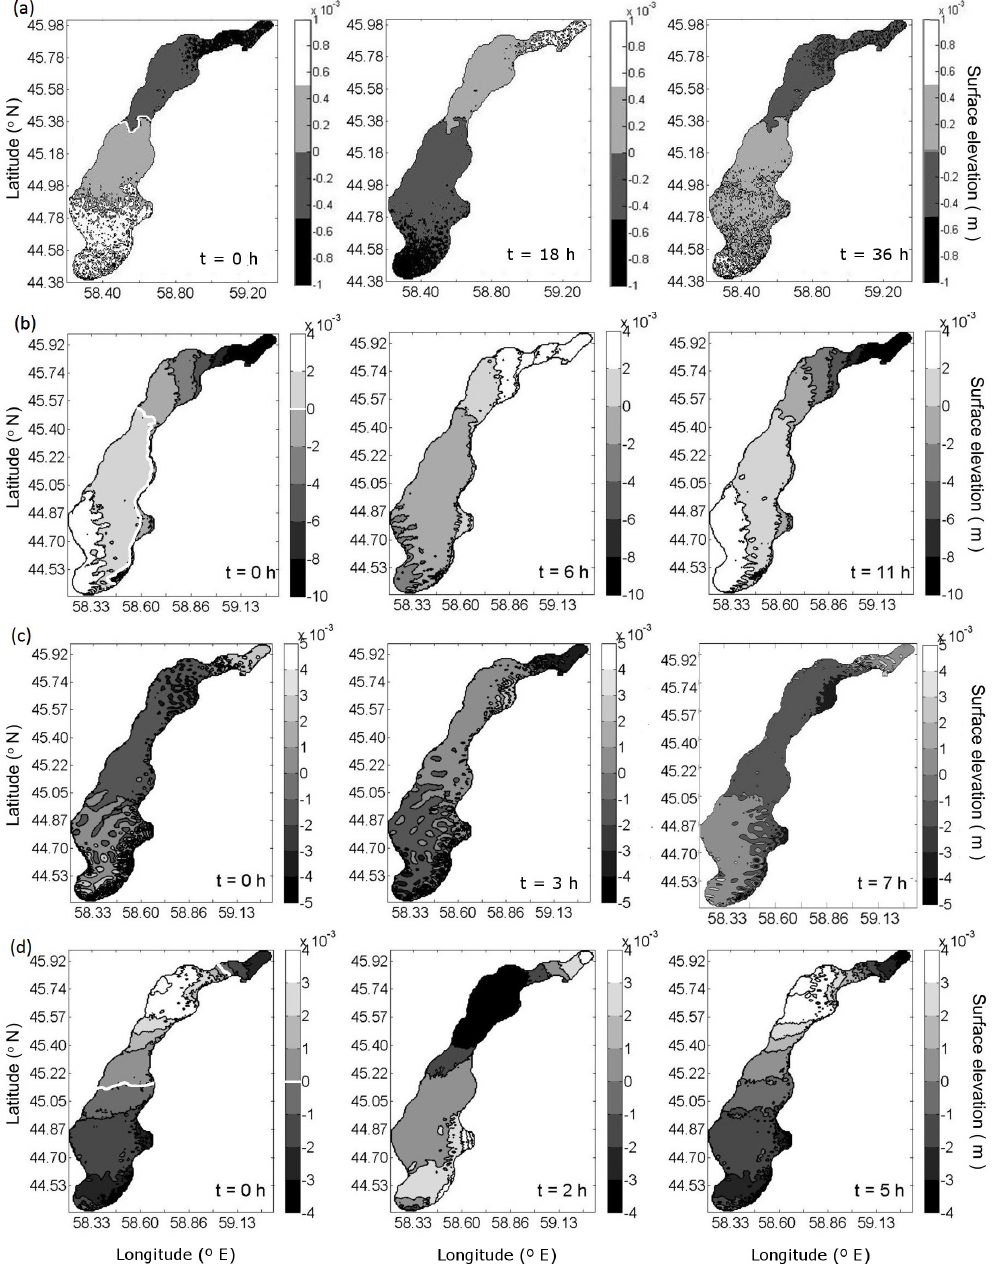
Figure 6. Band-pass-filtered surface elevations at three different times covering one oscillation of the internal seiches of (a) 36h, (b) 11h, (c) 7h and (d) 5h in